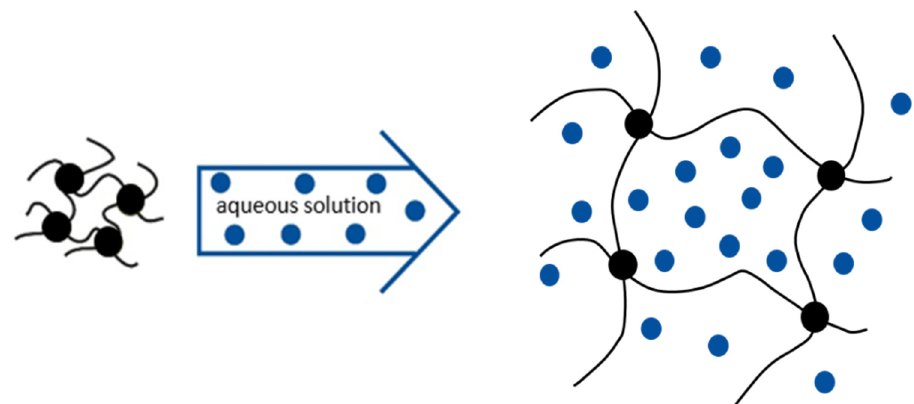
Figure 4. Polymerized hydrogels strongly increase in volume after immersion in aqueous solutions. After completed swelling, hydrogels consist of more than 90 vol% of the working fluid. Adapted from Jorsch [43].